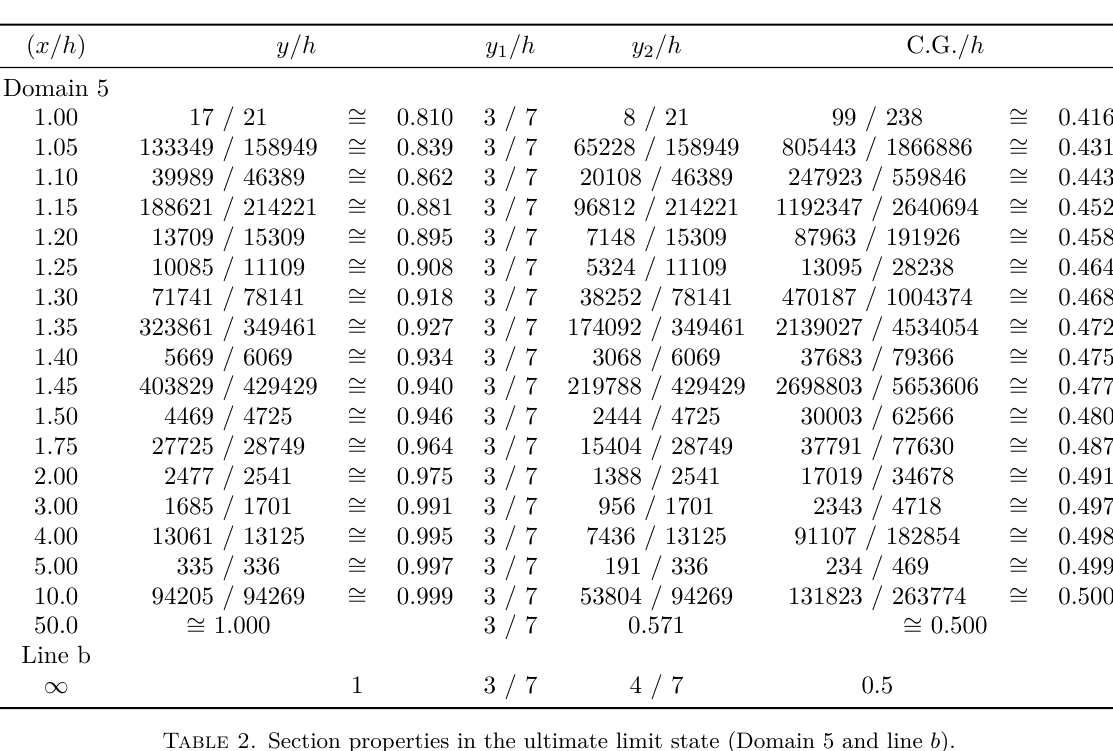
Table 2. Section properties in the ultimate limit state (Domain 5 and line b ).